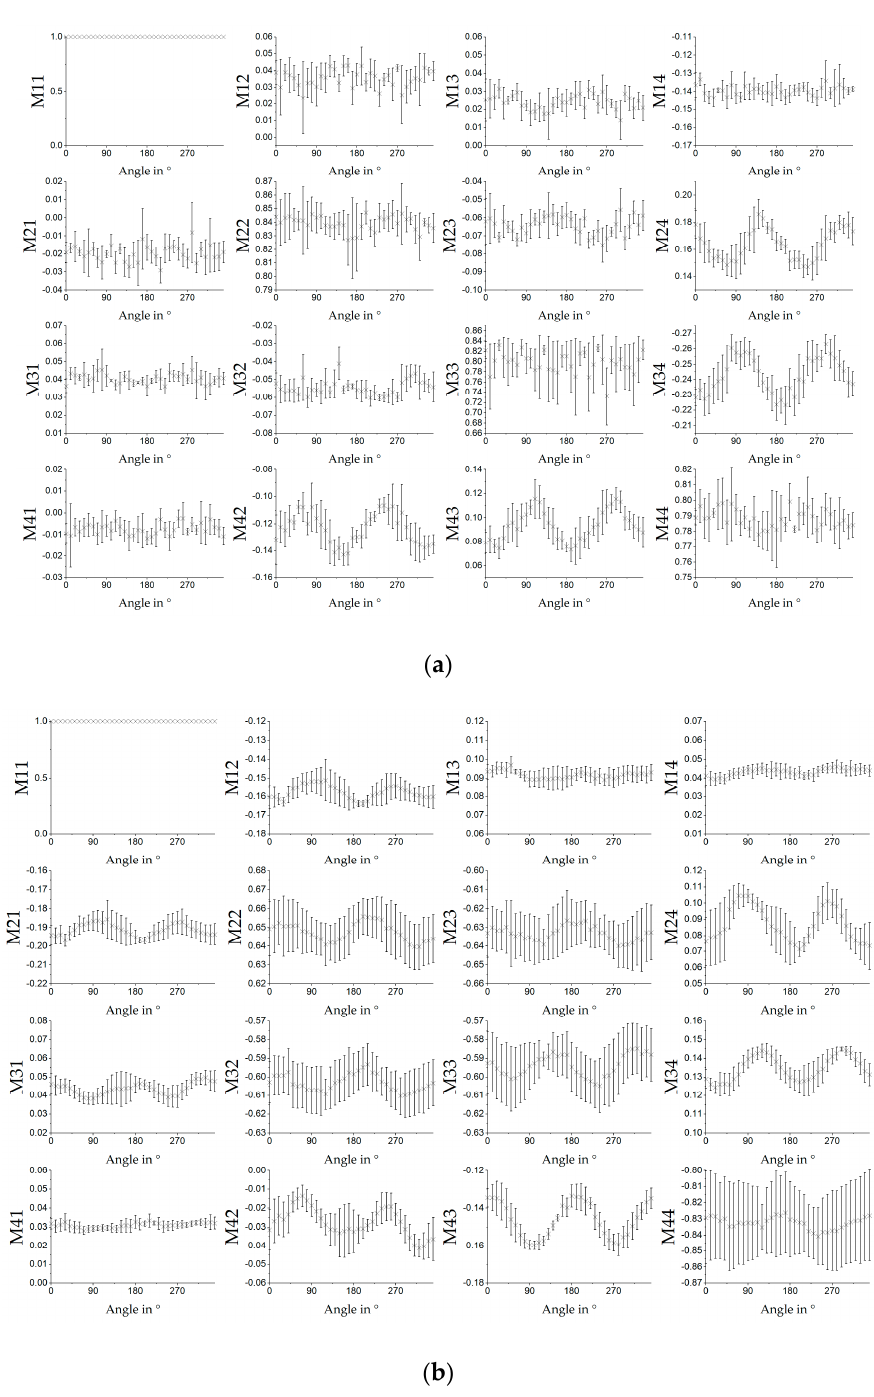
Figure 8. MM results for rotation of the transparent collagen film measured in ( a ) transmission and ( b ) reflection ( n = 5; ±SD) . Measurement was performed with 532 nm light source.